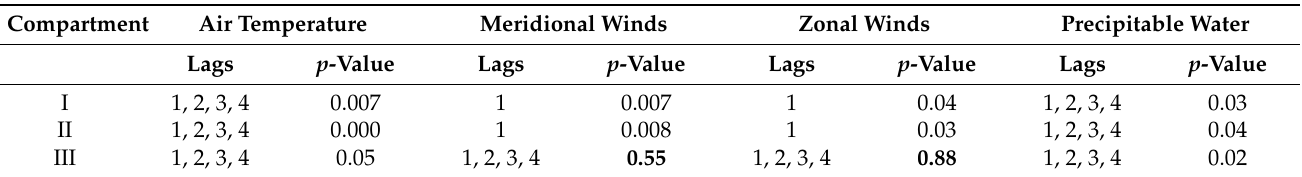
Table 4. Granger causality p -values and number of lags used for the models between the climate variables and mean NDVI of each compartment of the reservoir: near dam (I), reservoir body (II), and near river (III). Bolded are values that are statistically insignificant.